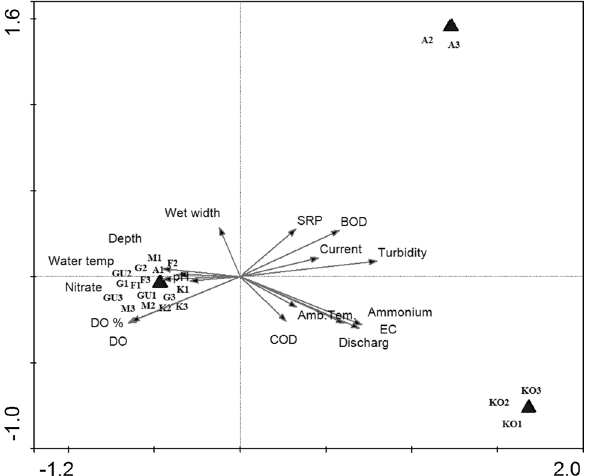
Fig. 2 Nonmetric Multidimensional Scaling (NMDS) analysis of physicochemical parameters of water across all stream sites of agri- cultural, forest and urban catchment area of southwest, Ethiopia. Stress value =